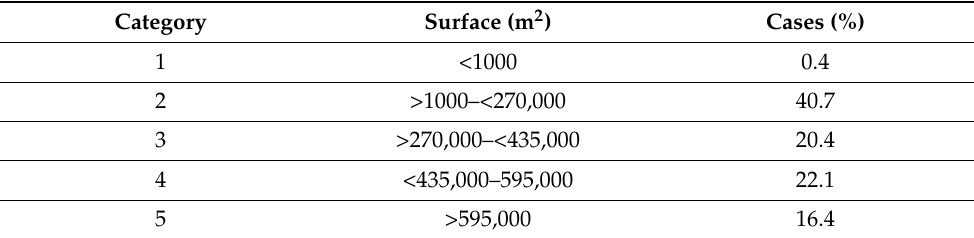
Table 4. Categorization of the views by